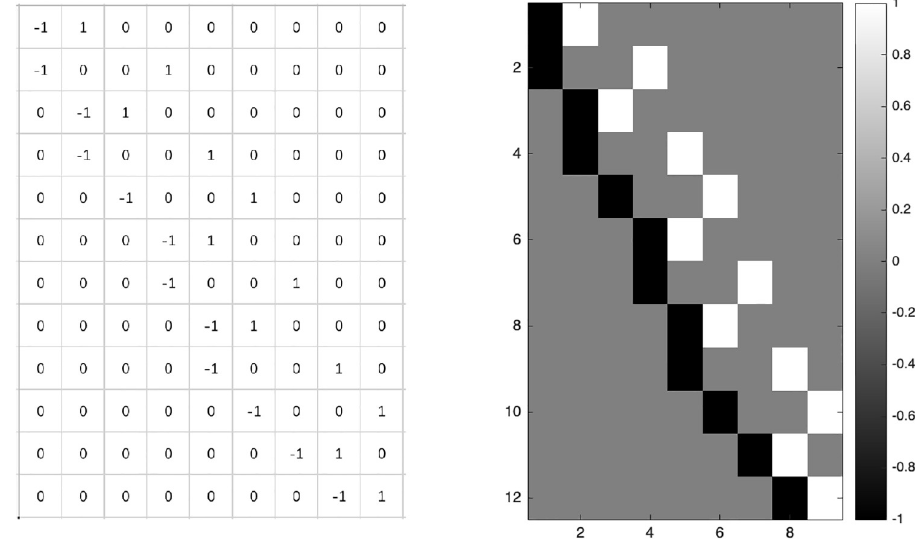
Fig 1. The matrix D in the case p = q =